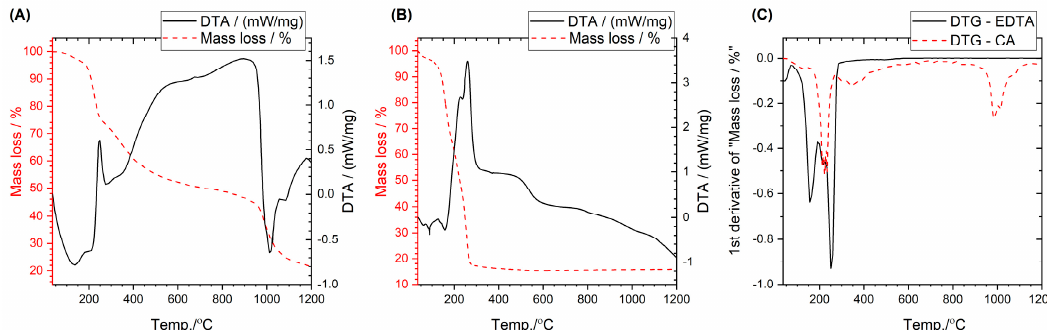
Figure 2. STA-measured graphs for dried LATP gels prepared using citric acid ( A ) and EDTA ( B ) complexing agent ( C ). The first derivative of the TG curve was calculated for two dried gel prepared by different synthesis routes. Lower reaction temperatures and eliminated mass loss at high temperatures can be seen in the case of EDTA-assisted gel.